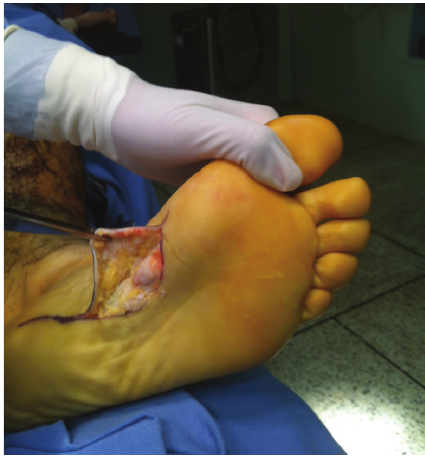
Figure 4: Dissection of the skin from the plantar fascia. Special care was taken to nourish the dermis.